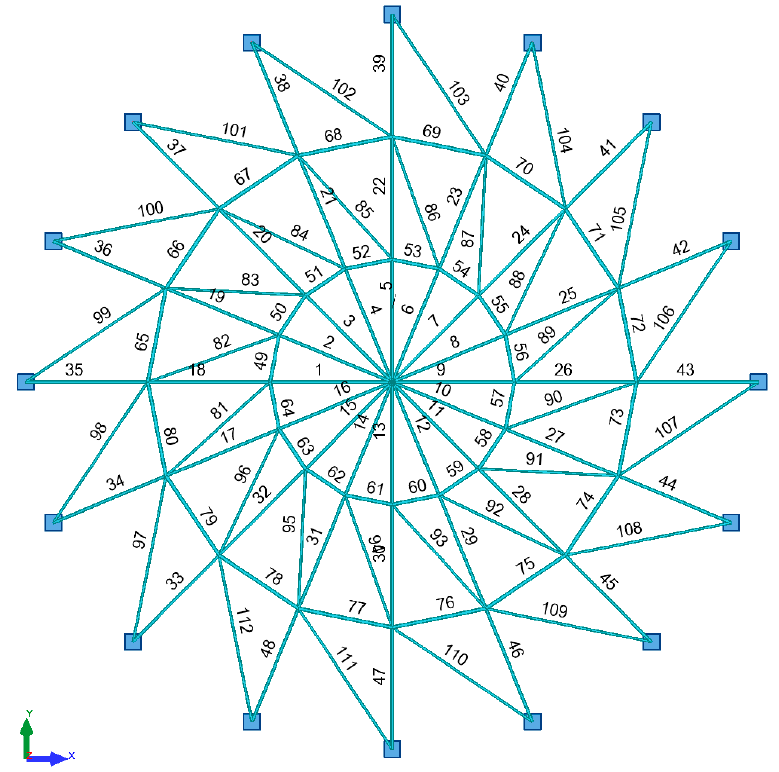
Figure 8. Lattice dome geometry. Table 1. Values of cross-sectional forces and load capacities for the most stressed structure elements and values of maximum vertical and horizontal displacements for nodes 2–17 in linear analysis.